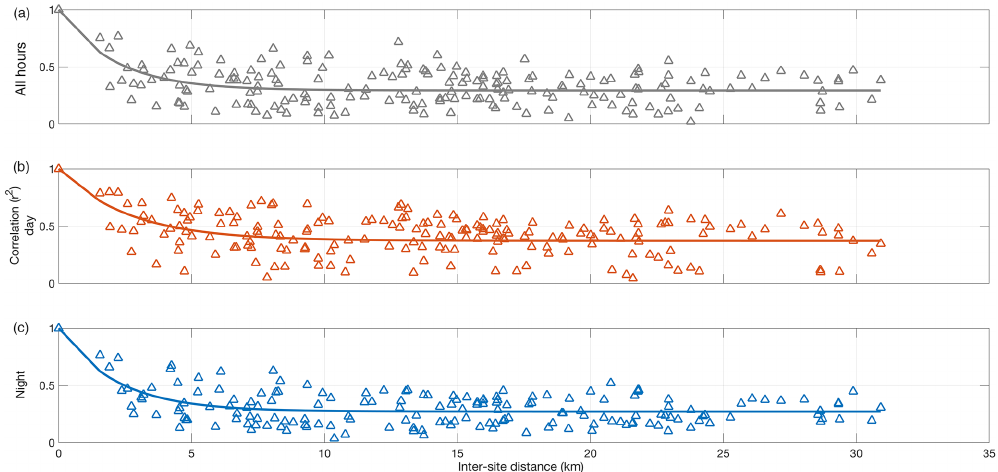
Figure 3. Optimal correlation coefficients for every possible pairing of winter 2017 sites as a function of their separation distance during all hours (a) , daytime hours (11:00–18:00LT, b ), and nighttime hours (2:100–04:00LT, c ). Solid lines show exponential decay of the correlation